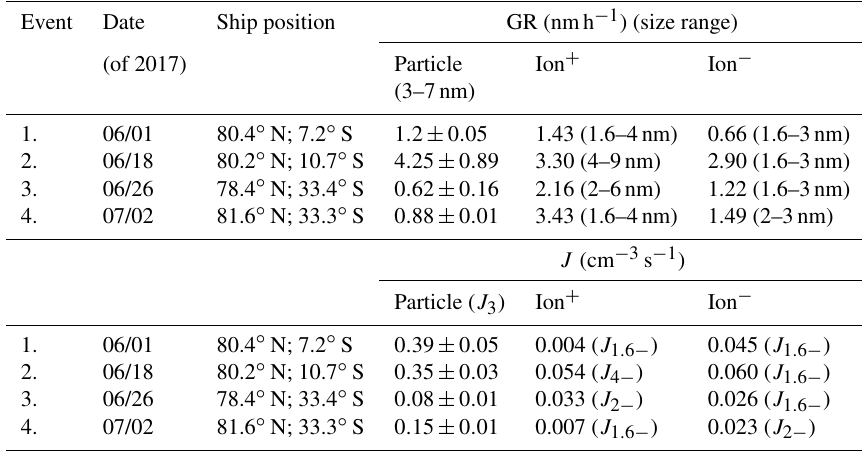
Table 1. Calculated parameters for observed NPF events during RV Polarstern cruise 106. The GR is obtained from the NAIS size spectrum using the methods proposed by Kulmala et al. (2012) and Pichelstorfer et al. (2018). J is the formation rate of 1.6nm sized positive/negative ion clusters and 3nm sized particles. Please note that in some instances the size range for GR and J calculations is different (due to measured PNSD). Nevertheless, we calculated both parameters from the smallest possible particle/ion size range. The value after “ ± ” shows the standard deviation. Date format: